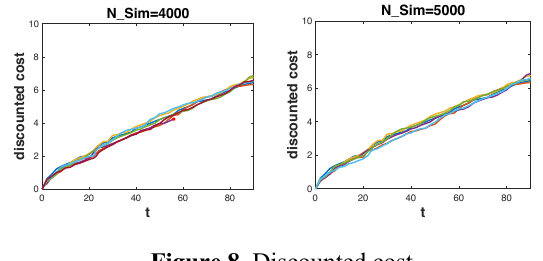
Figure 8. Discounted cost